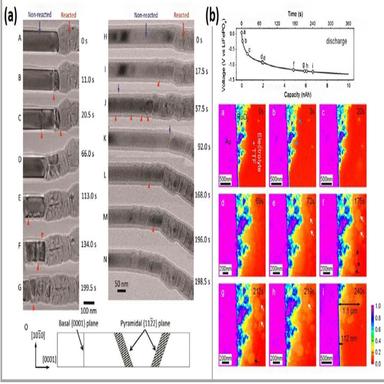
(a) In-situ TEM images of ZnO nanowires lithiation: The cracks formation and amorphization occurring at lithiation reaction front (Reproduced with permission from ref. Copyright 2011 American Chemical Society); (b) time-series of HAADF-STEM images tracing the generation of Li2O2 in Li-O2 batteries (Reproduced with permission from ref. Copyright 2020 American Chemical Society).